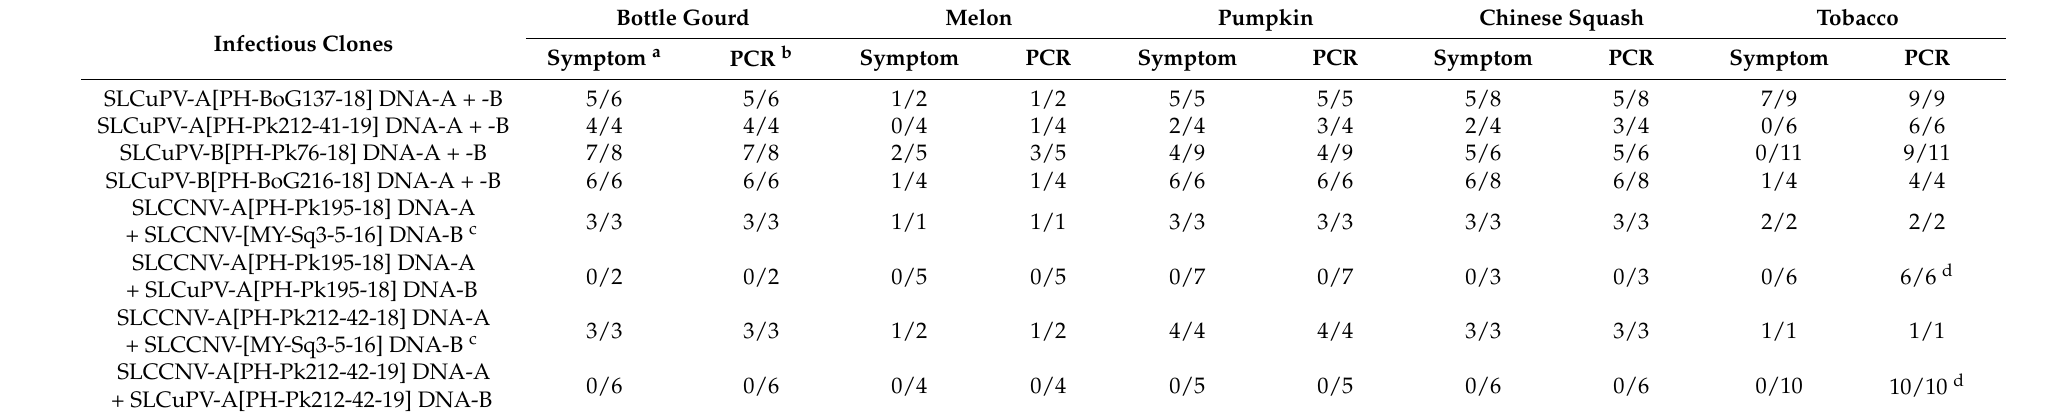
Table 3. Pathogenicity of SLCuPV infectious clones from the